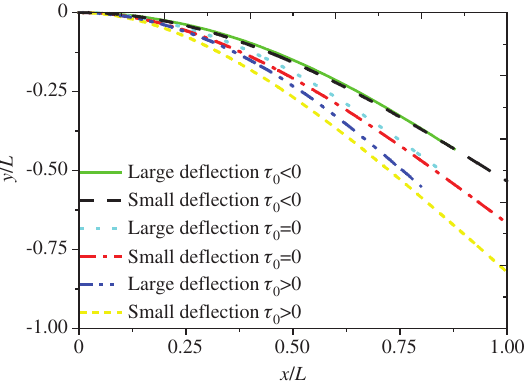
Figure 3 Deflection curves of a cantilever nanobeam in finite or infinitesimal deformation, with or without a surface effect [85].